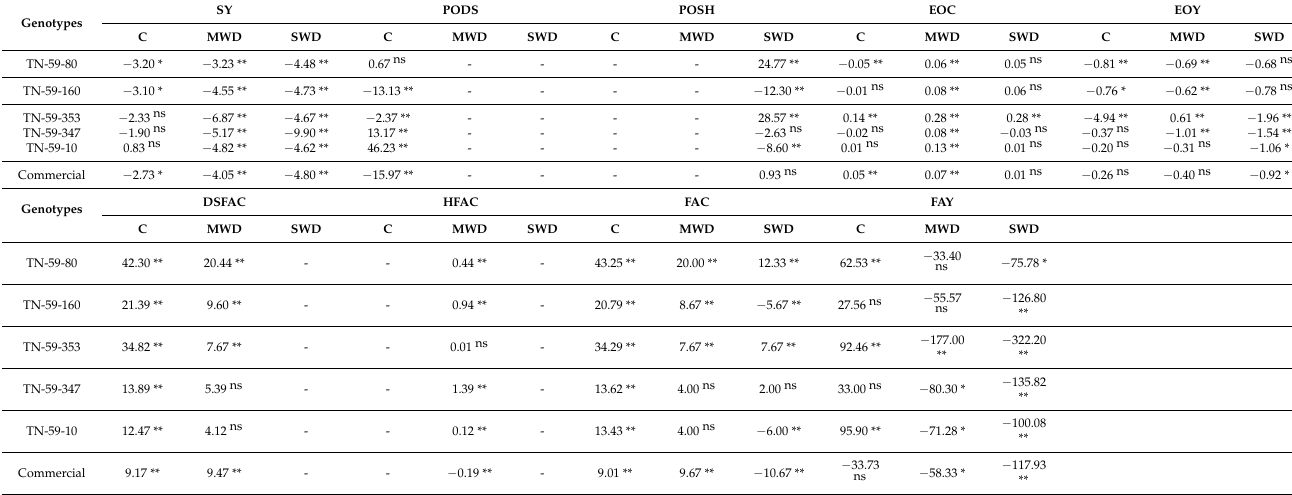
Table 7. Epistatic deviations of individual coriander genotypes SY, EOY, and FAY exhibiting significant differences among genotypes tested under control (C), moderate water deficit (MWD), and severe water deficit (SWD) conditions.